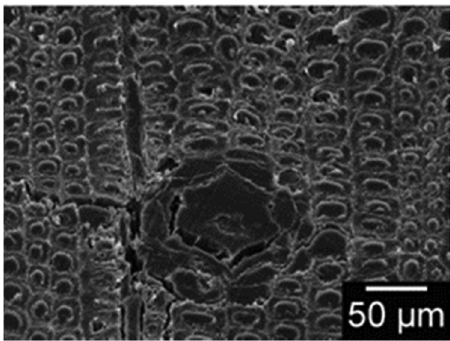
Figure 14: The cross section of the wax - treated material under an electron microscope [ 112